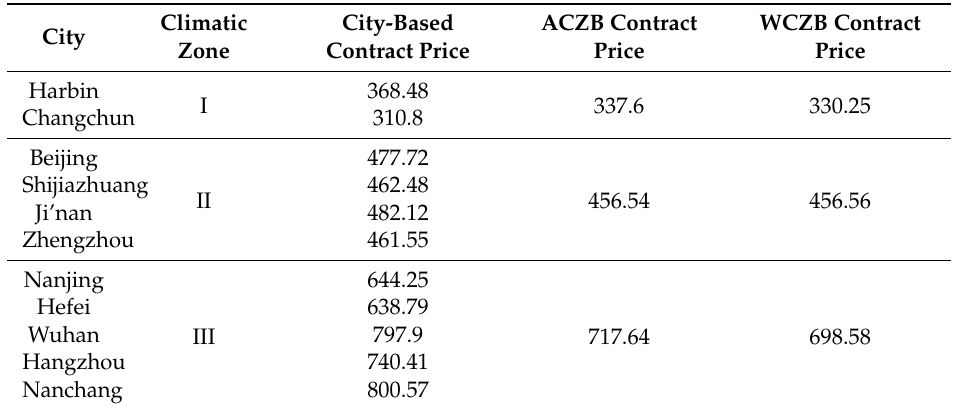
Table 2. GDD call option prices of city-based contracts, average climatic zone-based (ACZB) contracts and weighted climatic zone-based (WCZB) contracts (year: 2007; unit: RMB). City